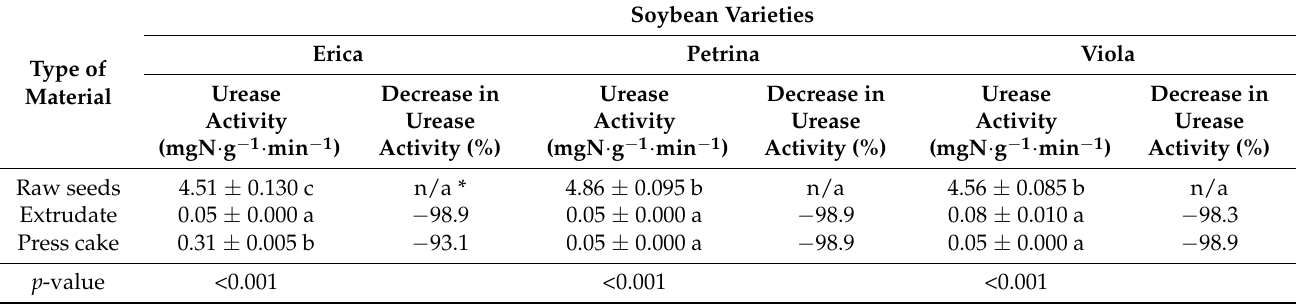
Table 5. The urease activity in the soybean seeds and processed feed products. The percentage difference shows a decrease in the urease activity in the processed feed materials, as compared with the raw seeds, in which the urease activity was assumed as